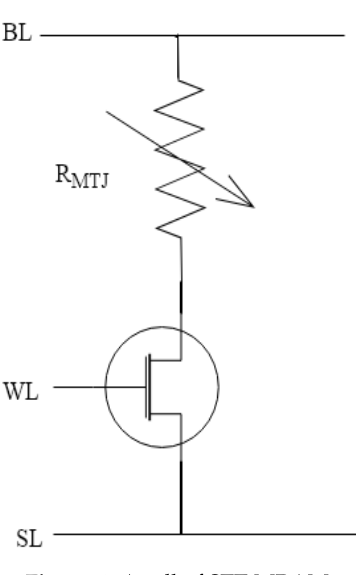
Figure 4. A cell of STT-MRAM.